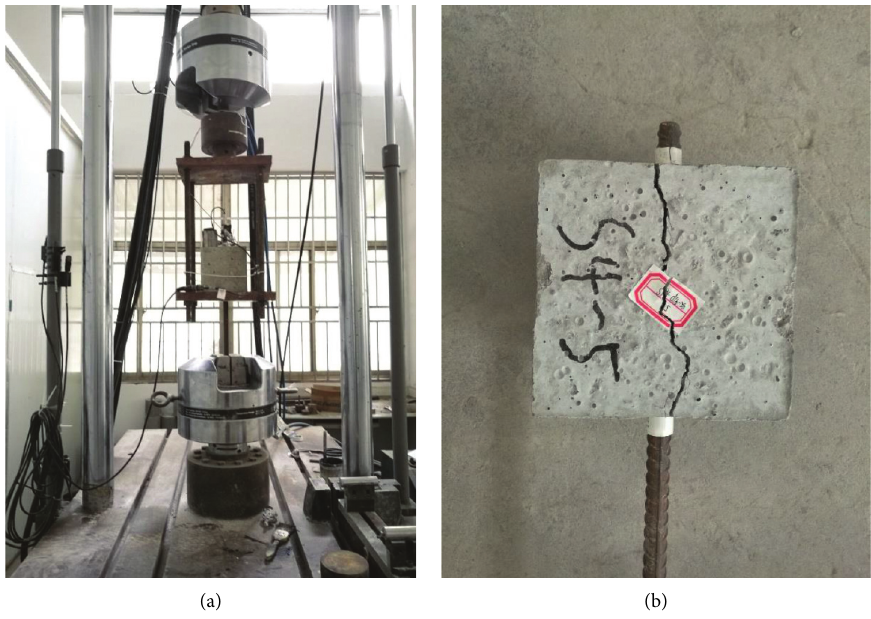
Figure 4: Pull-out test device. (a) Test instrument. (b) Split at